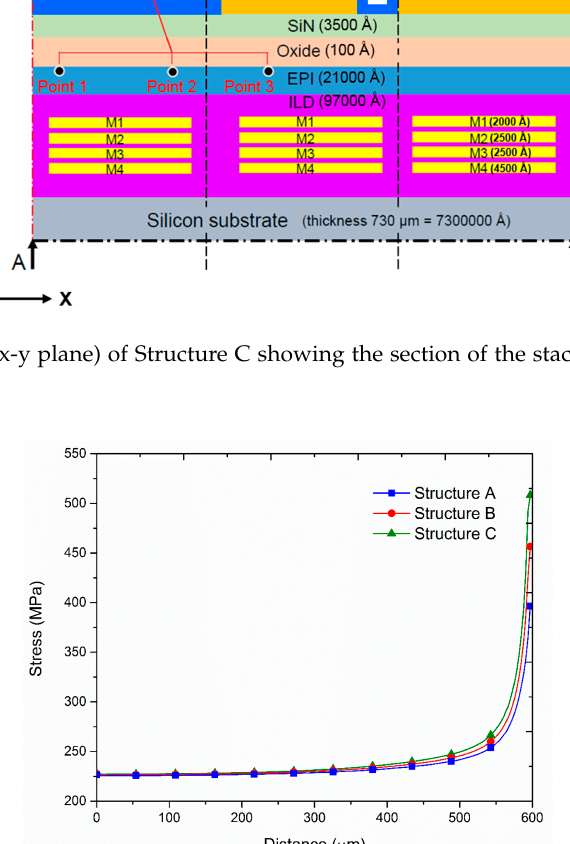
Figure 10. Simulated stress distributions in the cell areas.